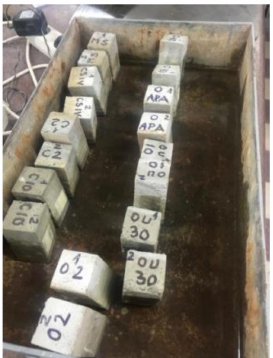
Figure 1. Immersed